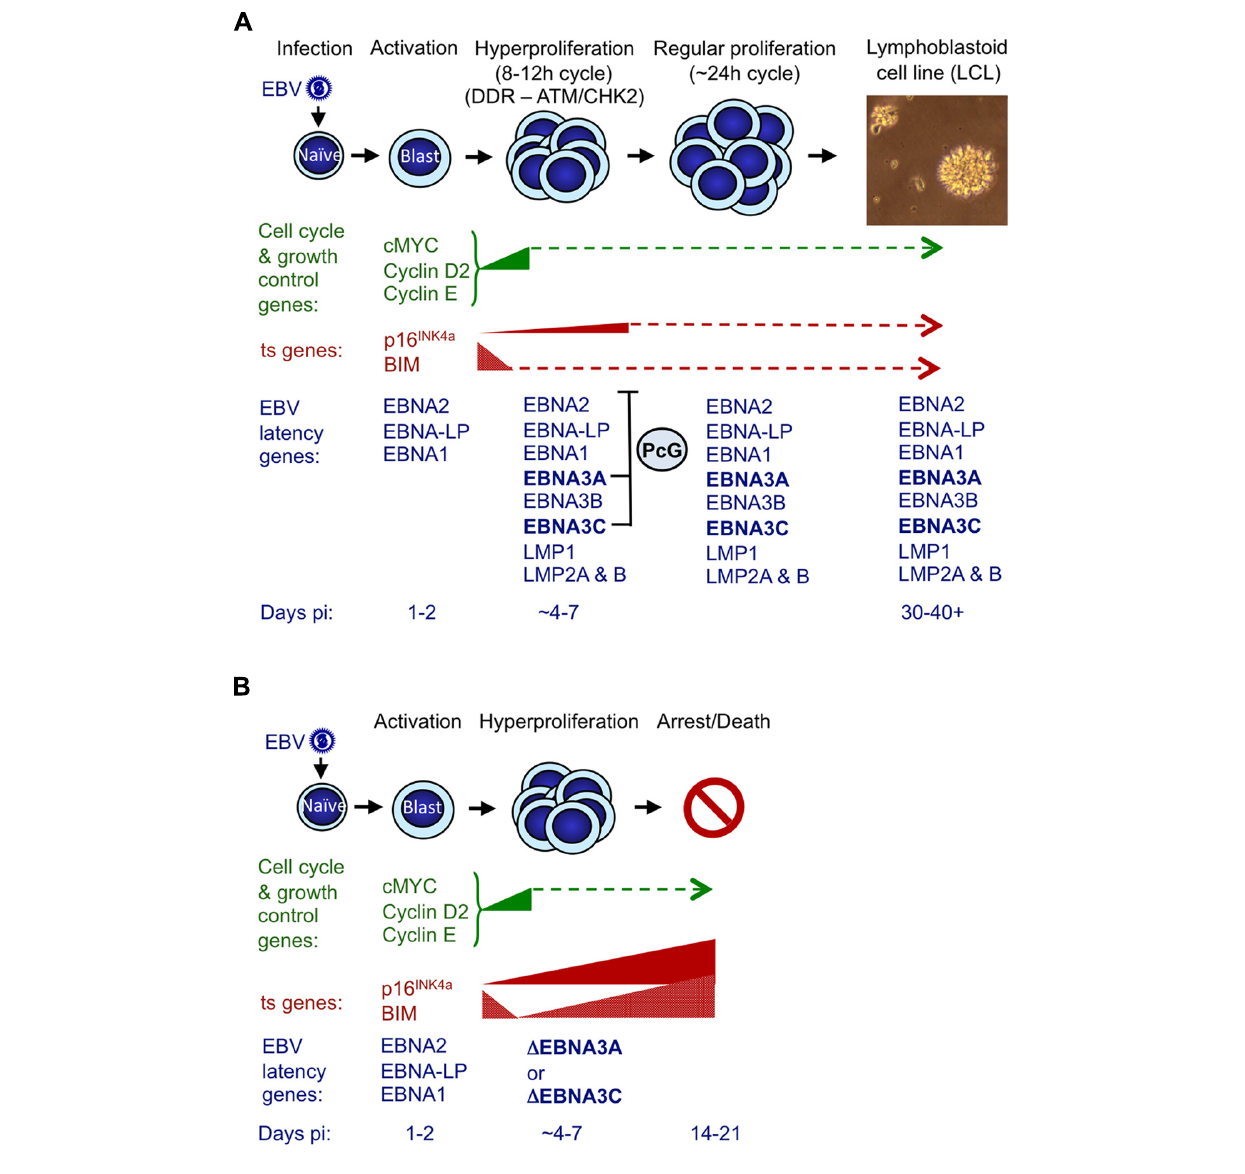
FIGURE 4 | Events following infection of primary resting B cells by EBV that initiate transformation into continuously proliferating LCLs. (A) During the first 24–48 h post-infection (pi) with a B95.8-derived EBV, cell genes associated with growth and cell cycle are transactivated and their products (e.g., MYC, cyclin D2, cyclin E) drive cells from G0 to G1, to become enlarged, activated and start proliferating. The whole process is driven by the EBV transactivator protein EBNA2, probably assisted by the co-factor EBNA-LP (Sinclair etal., 1994; Spender etal., 1999; Nikitin etal., 2010). During the next 3–4 days cells undergo rounds of rapid cell division (hyperproliferation) and in some cells this results in damage to DNA that can activate the DNA damage response (DDR) and initiate a signaling cascade involving the kinases ATM and CHK2 (Nikitin etal., 2010). If the full complement of nine EBV latency-associated proteins is expressed, the DDR becomes attenuated (in part by EBNA3C) and cells continue to proliferate to produce polyclonal LCLs that have a population doubling time of about 24 h. Early after infection BIM expression is down-regulated, and although the level of p16 INK4a expression increases slightly, this soon reaches a steady state. In both cases we assume that EBNA3A and